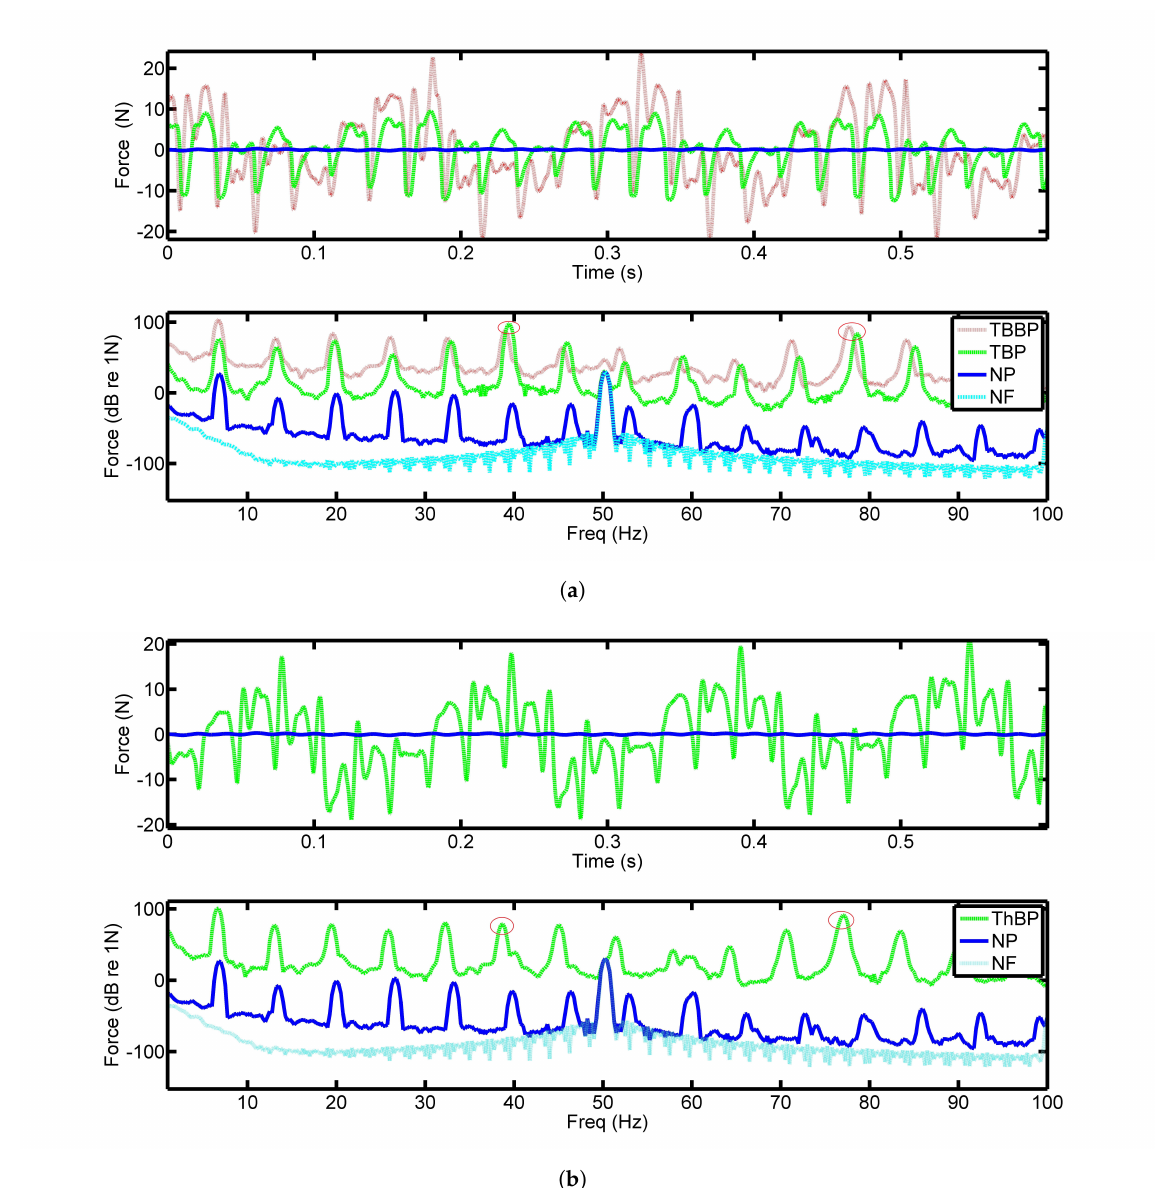
Figure 5. Captured force from the PVDF with the ( a ) two-blade propeller, ( b ) three-blade propeller rotating at 400 RPM with a six-pad bearing, time (top) and frequency (bottom) data. Where: TBBP–Two-blade brass propeller, TBP–Two-blade propeller, ThBP–Three-blade propeller, NP–No propeller, NF–Noise